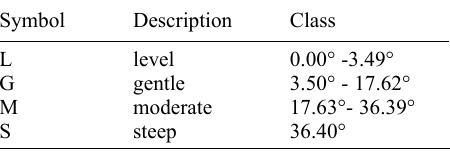
table: land type was read from the land type map (Land Type Survey Staff 1988); soil forms were clas- sified in accordance with MacVicar et al. (1977); the altitude of each sample plot was recorded using an altimeter and is given in metres; the slope of the ter- rain of each sample plot was measured in degrees, using an optical